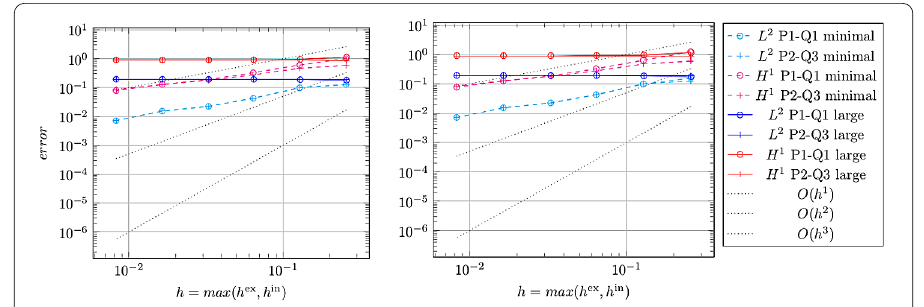
Figure 11 Congergence of MEM II. Convergence in L 2 and H 1 of the scheme MEM 0,0 using L 2 -projection (left) or nodal interpolation (right)